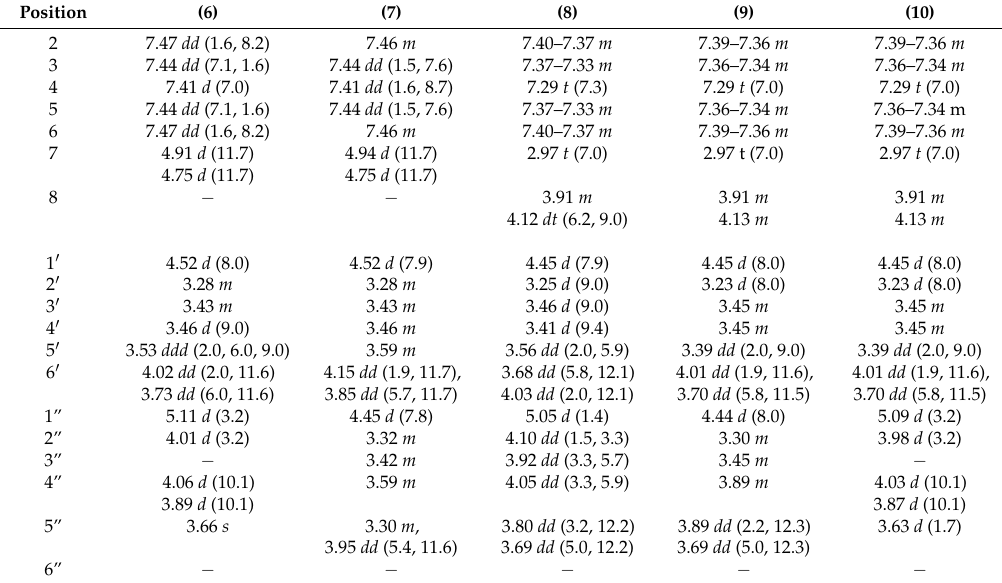
Table 4. 1 H-NMR data of benzyl disaccharides found in S. triandra × dasyclados hybrid (NWC1283) wood chip